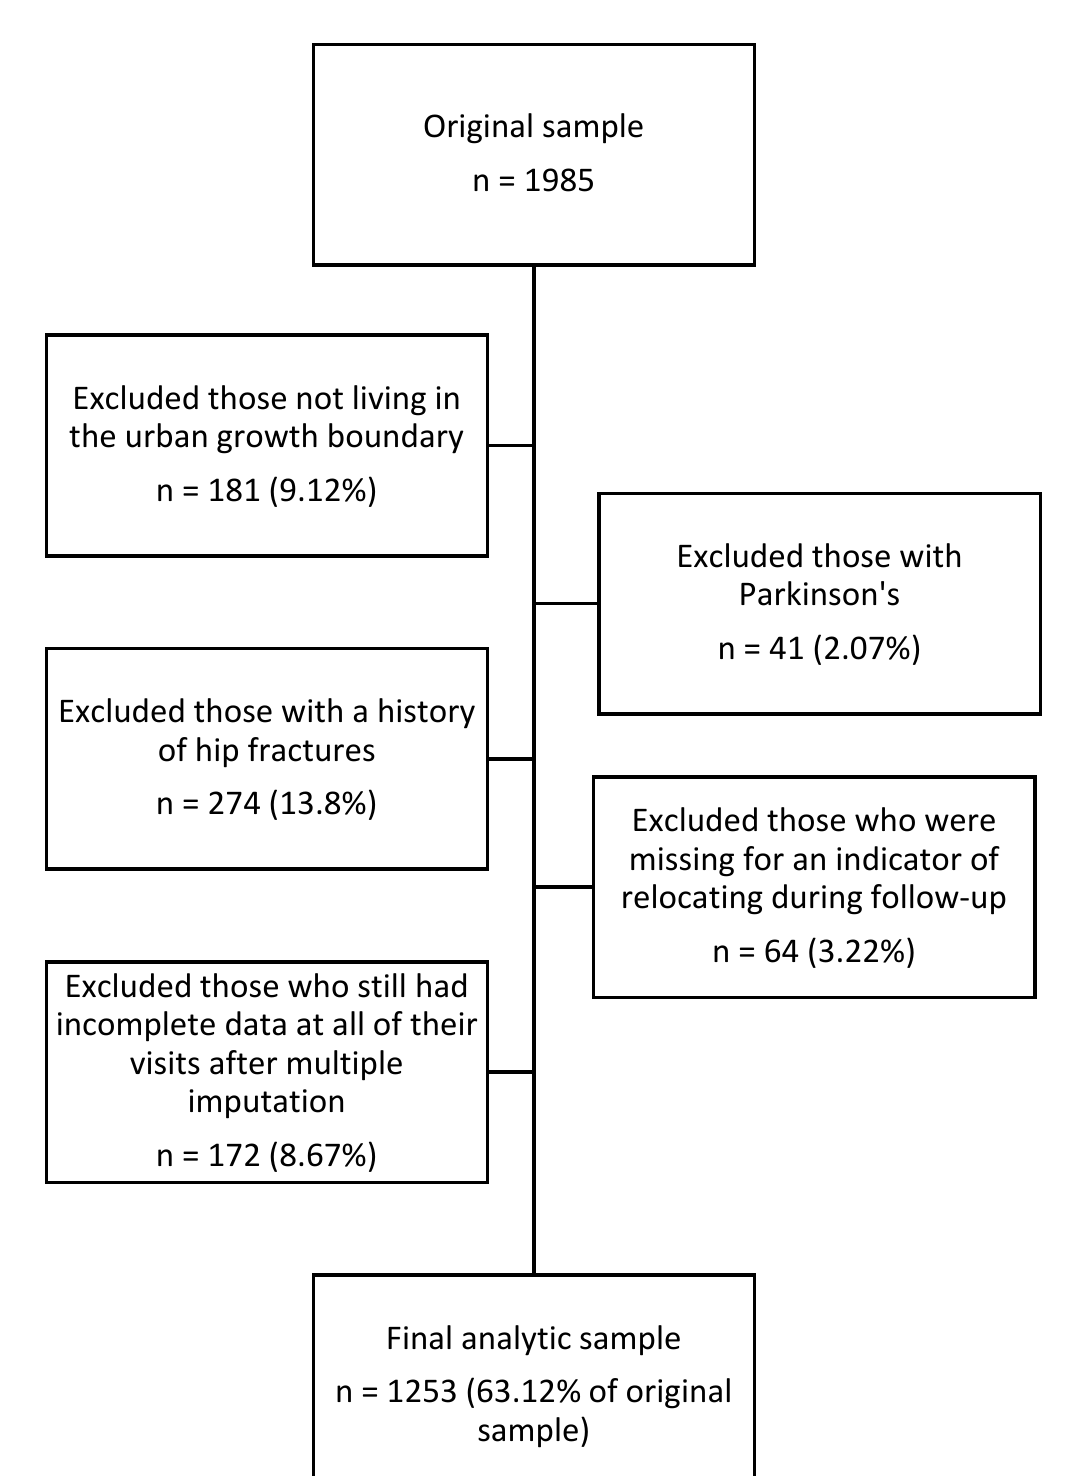
Figure A1. Spaghetti plot to identify the function of time.